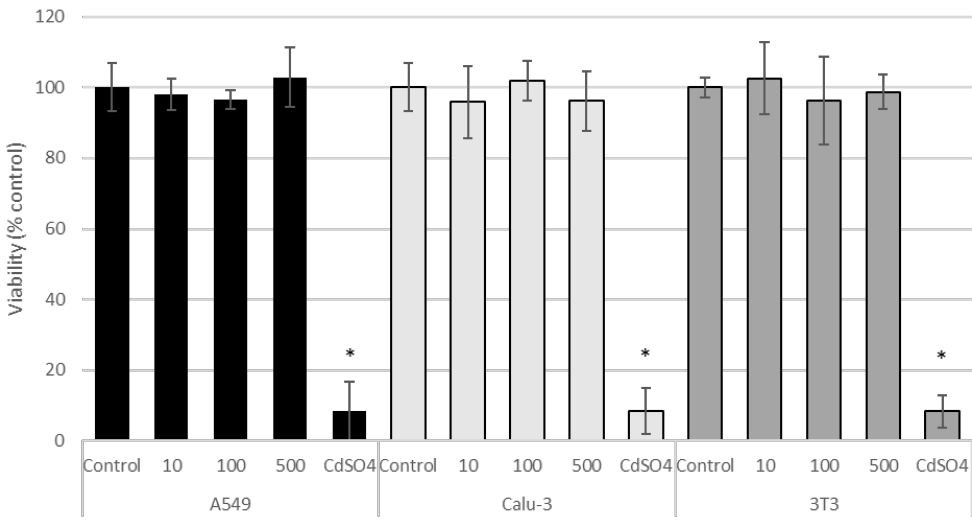
Figure 5. Cell viability (MTT assay) of control A549, Calu-3, and 3T3 cells, and of cells exposed for 24 h to CeO 2 -NPs (10, 100, and 500 µg/mL). Results are expressed as means ± SD of six replicates per tested condition and three independent assays ( n = 18). Asterisks indicate significant differences with respect to the untreated control cells ( p < 0.05).